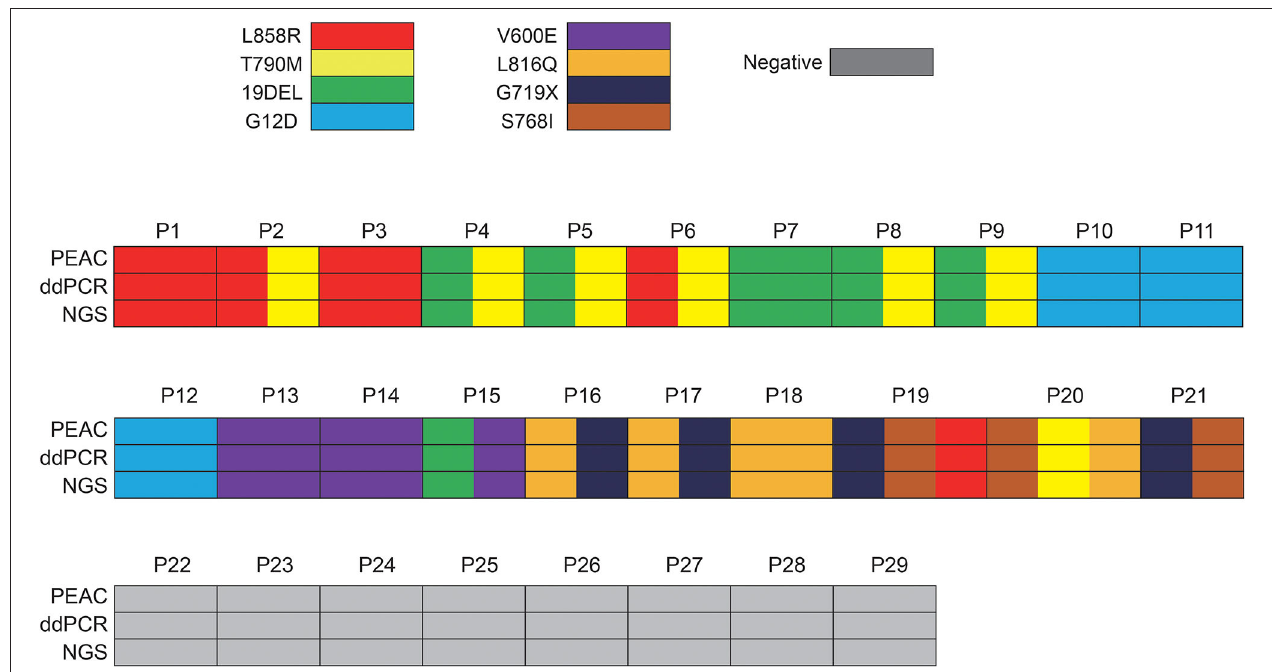
FIGURE 4 | Demographics and comparison of 29 patients who received ctDNA liquid biopsy by ddPCR, NGS and PEAC following Sanger. Of these 29 patients, 21 patients harbored 8 NSCLC driver mutations including EGFR L858R, T790M, 19DEL, S768I, L861Q and G719X, KRAS G12D, and BRAF V600E, 8 patients had no mutations detected. Some patients have more than one mutation detected. The concordance rate among PEAC, ddPCR, and NGS was 100%.